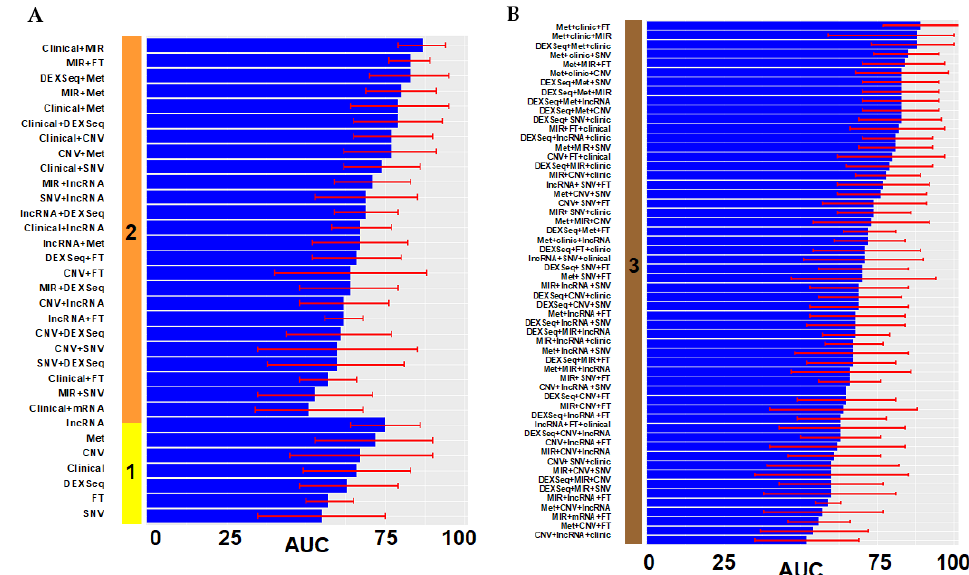
Figure 4. Performance of prediction models of complete cytoreduction. ( A ) The solid vertical bar represents the number of types of data: 1 (yellow): only one variable was included in the model; 2 (orange): a combination of 2 types of variables. ( B ). Panel with combination of 3 types of variables: solid vertical line with 3 tags (maroon). Different performances on both panels are displayed in ascending order. The x axis is the AUC as a percentage (0–100%). The red error mark displays the 95% confidence interval (CI). Overall, 89 additional models with different combinations of data were tested. FT: fusion transcripts; Met: DNA methylation; SNV: single nucleotide variation; CNV: gene copy number; DEXSeq: exon expression; lncRNA: long non ‐ coding RNA; MIR: micro RNA, mRNA: gene expression. Graphics were generated with R package ggplot .